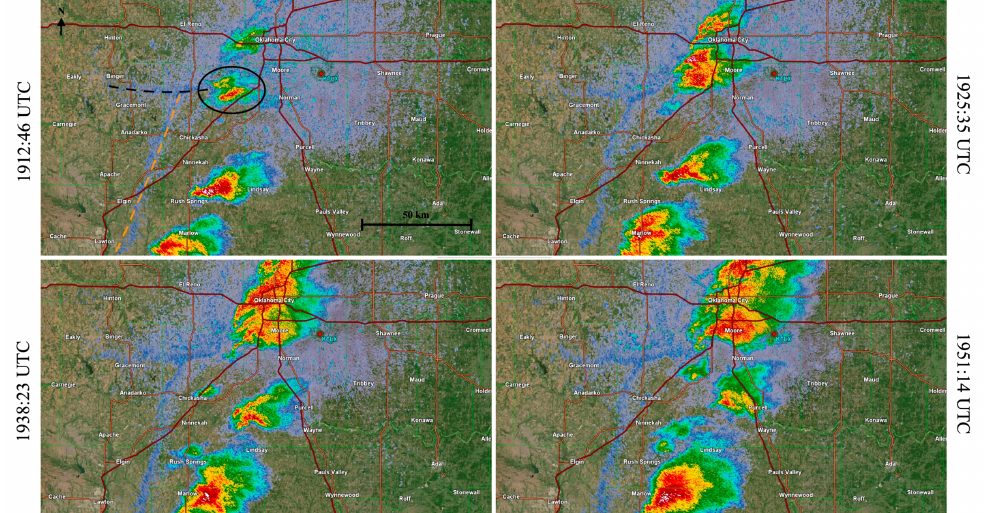
Figure 2. Sequential evolution of reflectivity ( Z H ) as observed by KTLX at 0.5 ◦ , highlighting the interaction of the Moore supercell (circled in first panel) with the dryline (dashed orange) and east–west oriented boundary (dashed black). Time is formatted HHMM:SS. Images created from GR2Analyst